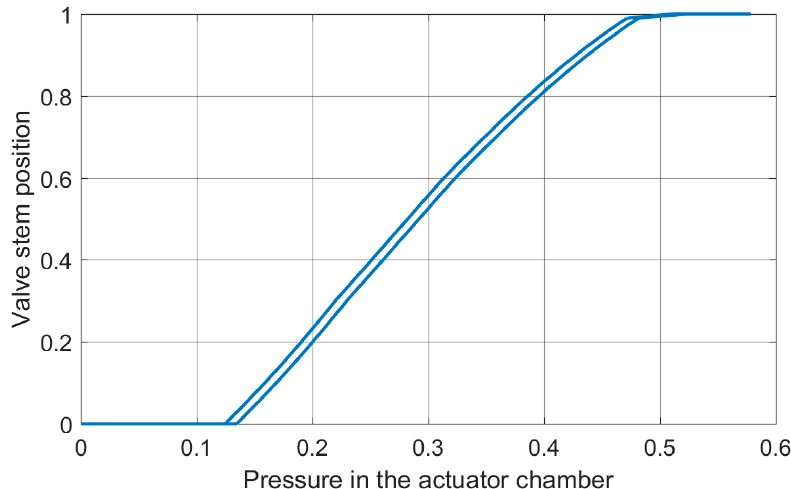
Figure 7. Normalized static characteristics of pneumatic actuator of the electro-pneumatic final control element.